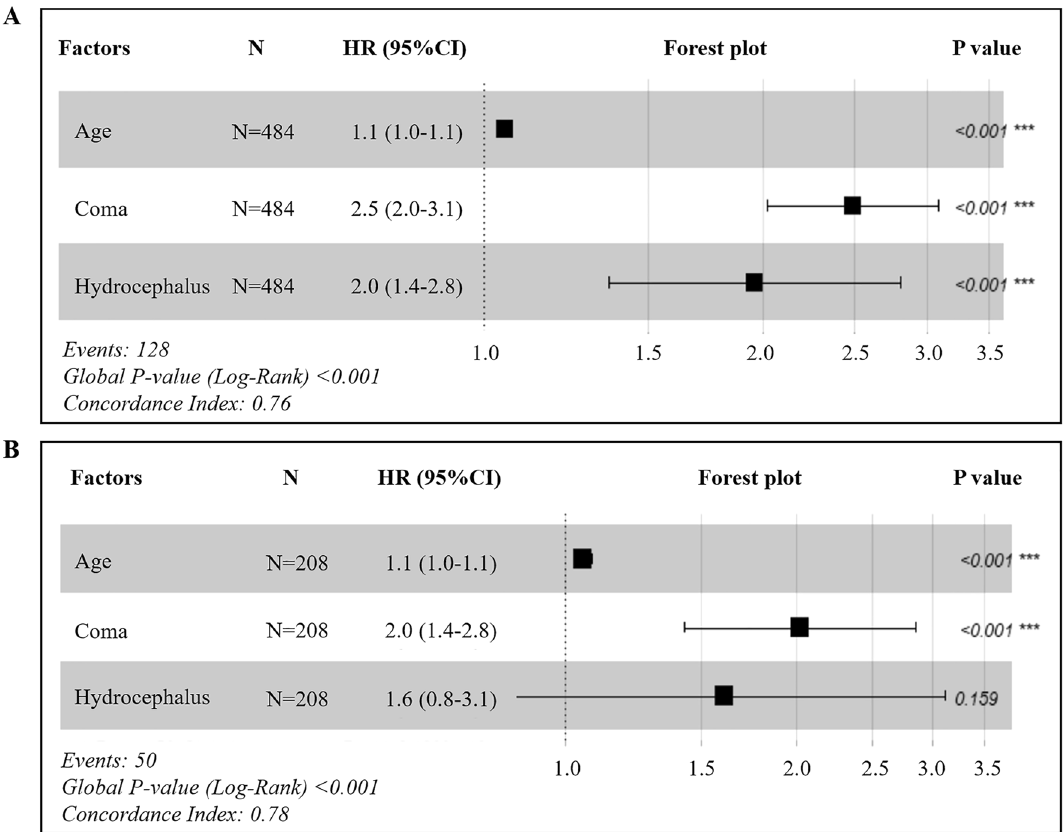
Figure 3. Hazard factors associated with death in sICH patients. ( A ) Forest plot of training set. ( B ) Forest plot of validation set. HR, Hazard Ratio. COX proportional analysis was performed with Survival R package version 3.3–1 (Threneau 2022) and Survminer R package version 0.4.9 (Kassambara et al. 2021). Forest plots were generated with ggplot2 R library (Wickham